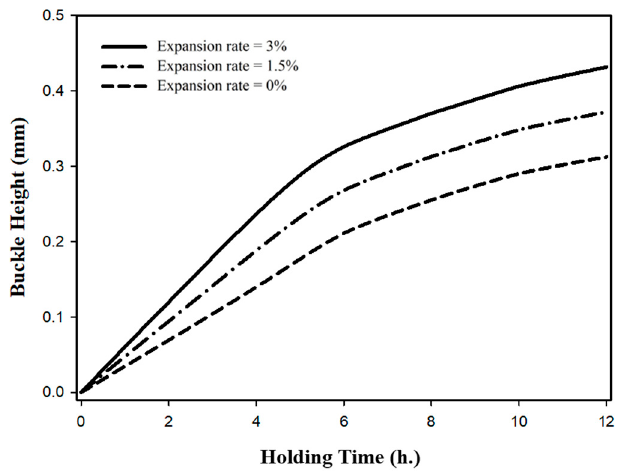
Figure 7. Buckle height of YSZ induced by CMAS infiltration for different holding times with three different expansion rates.